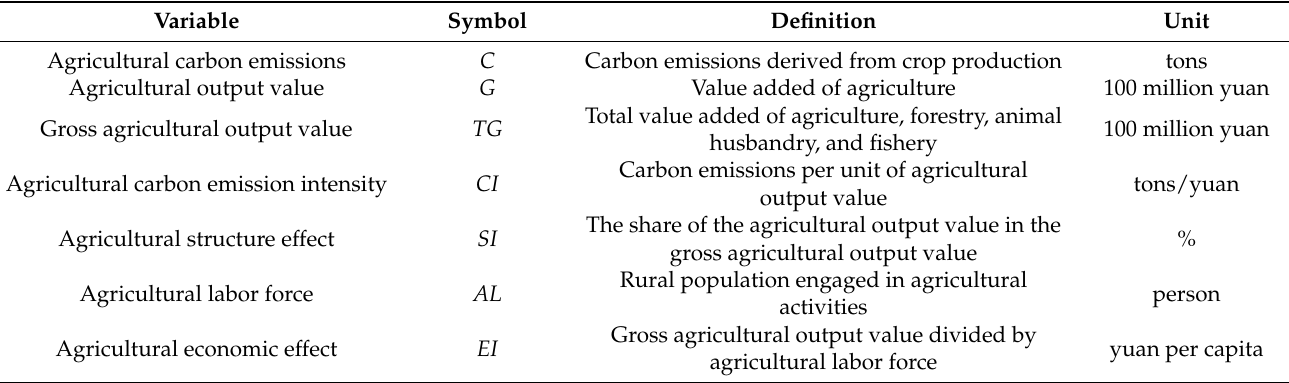
Table 2. Definition of variables in the LMDI